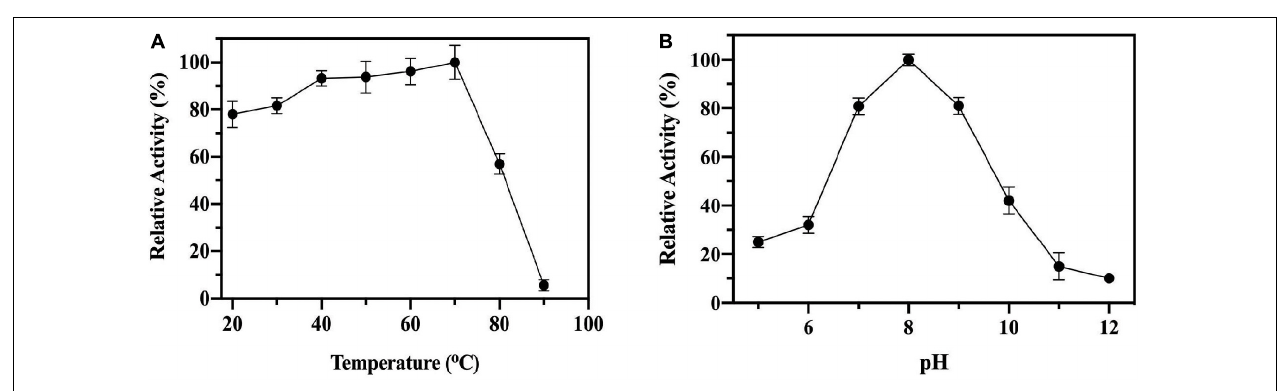
FIGURE 2 | The biochemical characterization of ChTK-F. (A) The percentage of relative enzyme activity for ChTK-F after incubation for 1 h at a range of temperatures indicated against a control kept at room temperature in a reaction with HPA as a ketol donor and glycolaldehyde as an acceptor. (B) The percentage of relative activity for ChTK-F after incubation for 1 h at different